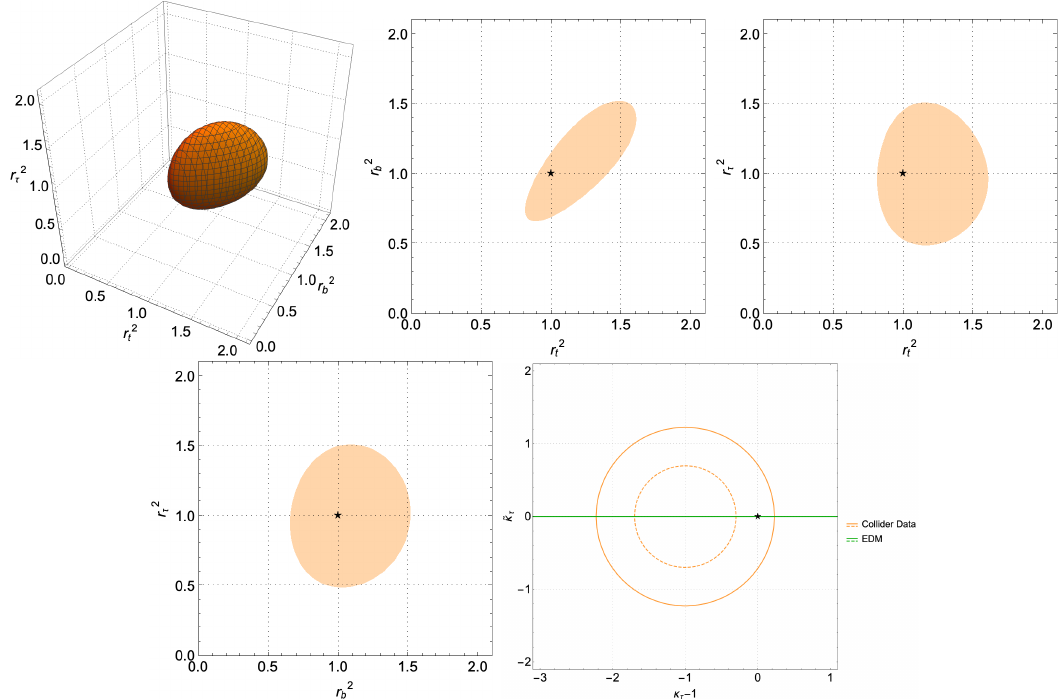
Figure 2 . Bounds in the r 2 - r 0 2 planes, with NP contributions to all the Yukawa couplings. The ψ ψ MFV case is shown and the FN one is very similar. The plot on top-left is the main result of the χ 2 fit, and the following three ones are the projections in two-dimensions. The last plot shows the κ τ − ˜ κ τ parameter space: in orange the result of the global χ 2 fit and in green the EDM bound as reported in eq. (3.8). The SM case ( r 2 = 1 or κ τ − 1 = ˜ κ τ = 0 ) is represented with a ψ